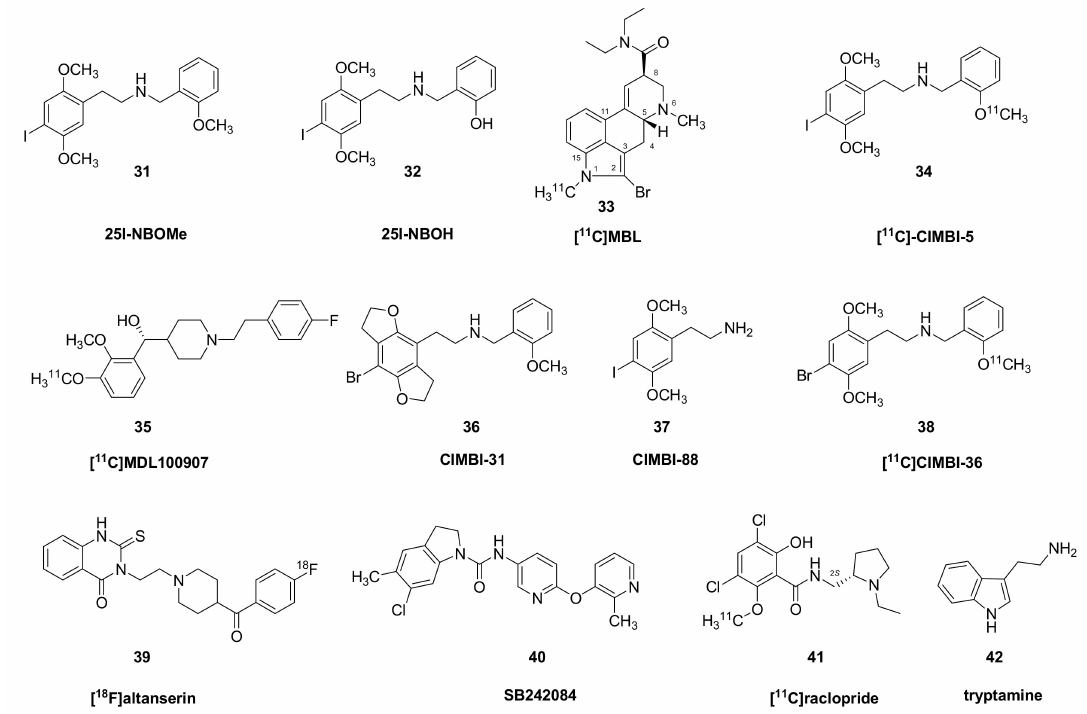
Figure 3. Structures of some dimethoxyamphetamines and serotonin receptor